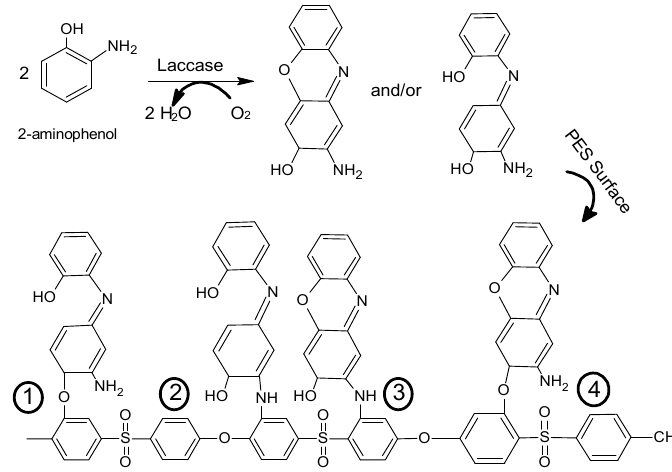
Figure 13. Schematic representation of four possible chemical structures of the poly(ethersulfone) (PES) surface after modification with 2-aminophenol, containing O-linked and N-linked structures.